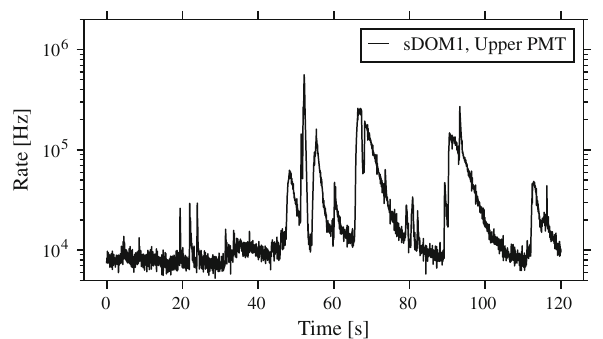
Fig. 10 Rateofasinglephotomultiplierover2min,measuredin30ms intervals. There is a characteristic structure of a constant background with spikes caused by bioluminescence, typically of the order of a few seconds